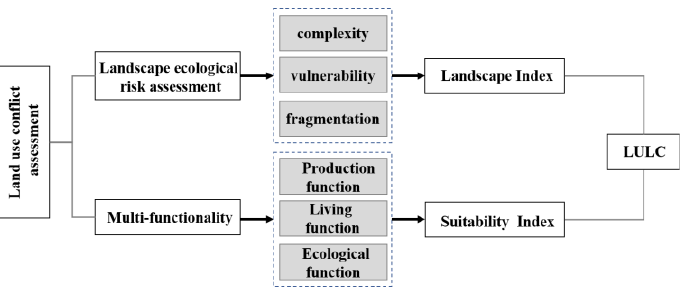
Figure 2. Conceptual framework of land-use conflict assessment and correlation with LULC.